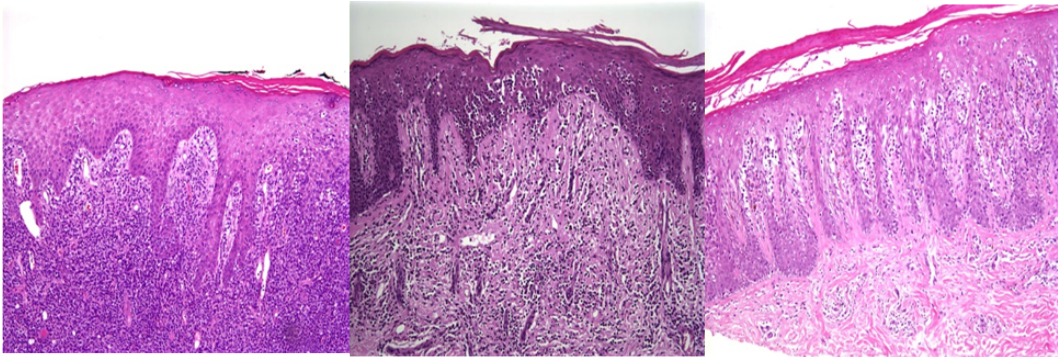
Figure 2. In pathological view, the cutaneous T cell lymphomas are characterized by haloed lymphocytes, exocytosis, epidermotropism, Pautrier’s microabscess, large hyperconvoluted, hyperchromatic lymphocytes in the epidermis, and lymphocytes aligned within the basal layer. Figure 2A (left) A lymphocytic infiltrate is present in the dermis and extending into the overlying epidermis with minimal overlying spongiosis. Figure 2B (center) Lymphocytes with surrounding haloes are present in the epidermis as single cells and small clusters (Pautrier’s microabscesses). There is minimal accompanying spongiosis. Figure 2C (right) Psoriasiform epidermal hyperplasia with epidermotropism of haloed lymphocytes is seen in this case of patch-stage mycosis